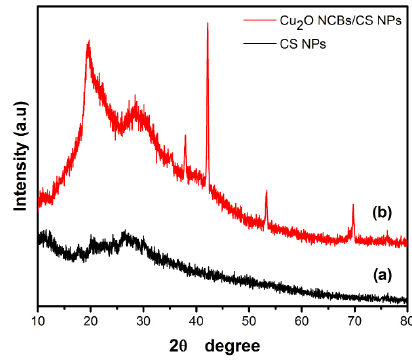
Fig. 2. FTIR spectra of (a) Cu composites and (b) CS NPs, respectively.